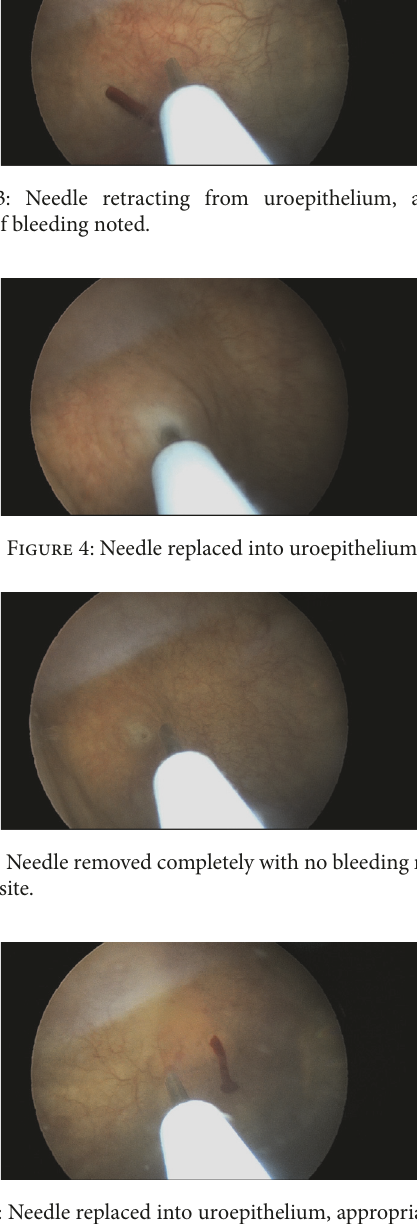
Figure 6: Needle replaced into uroepithelium, appropriate amount of bleeding